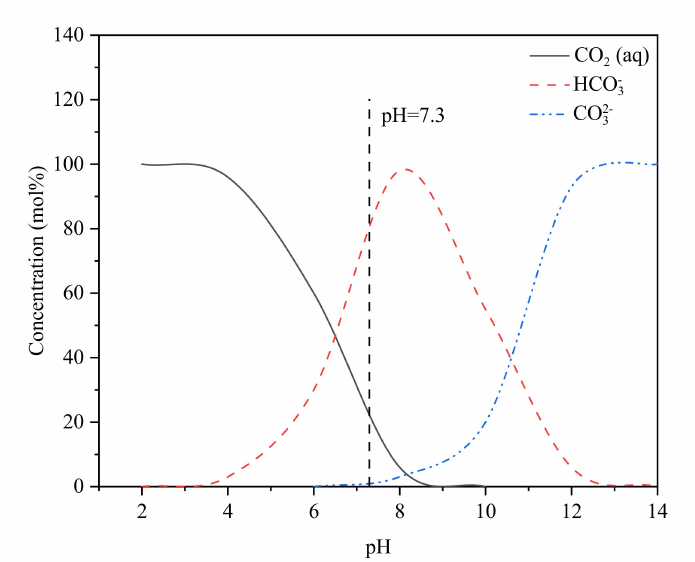
Figure 5. Concentrations of aqueous CO 2 , HCO 3 − , and CO 32 − for each pH (mol%). In order to test the relations between contents of Ca 2+ and Mg 2+ in leaching solution of slag and concentration of CO 2 (aq), 50, 100, 200, and 400 mg/L Ca(OH) 2 and MgO were added into F/2 medium, respectively. Then concentration of CO 2 (aq) in compound was tested. As is shown in Figure 6, the concentration of Ca(OH) 2 was related to the concentra- tion of CO 2 (aq). The concentration of CO 2 (aq) increased with the increase in concentration of Ca(OH) 2 . However, since its solubility was relatively low, the concentration of MgO in the test concentration range showed no great effects on the concentration of CO 2 (aq) in the compound.